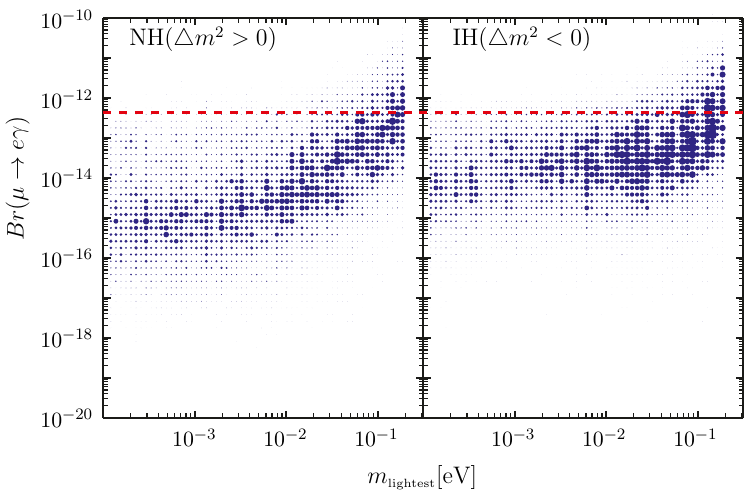
Figure 4 . The log-log plot of Br ( µ left/right panel. The red dash line indicates the current experimental bound [42]. The radius of each dot is proportional to the number of found solutions in the corresponding Br